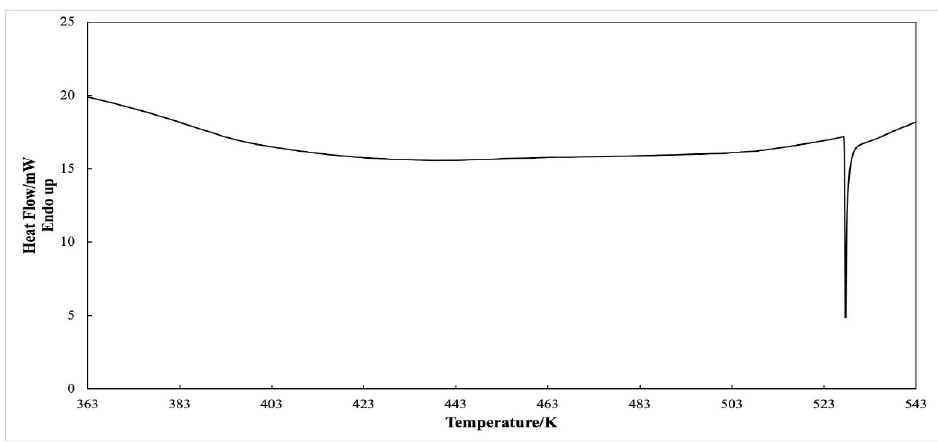
Figure 7. DSC curve of the cathode for a new cell.